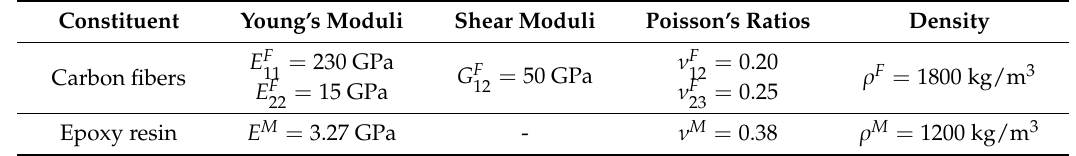
Table 2. Mechanical properties of the layer constituents.